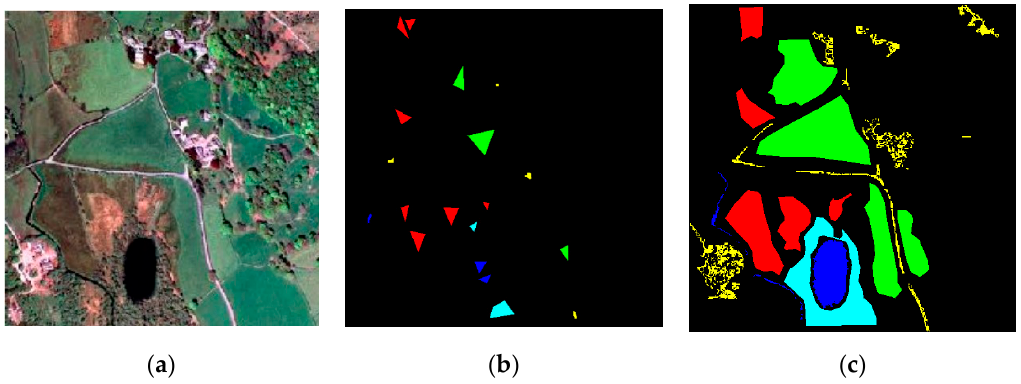
Figure 7. The three-channel image in pseudo-color representation ( a ); pixel groups used for training ( b ), pixel groups used for verification ( c ).